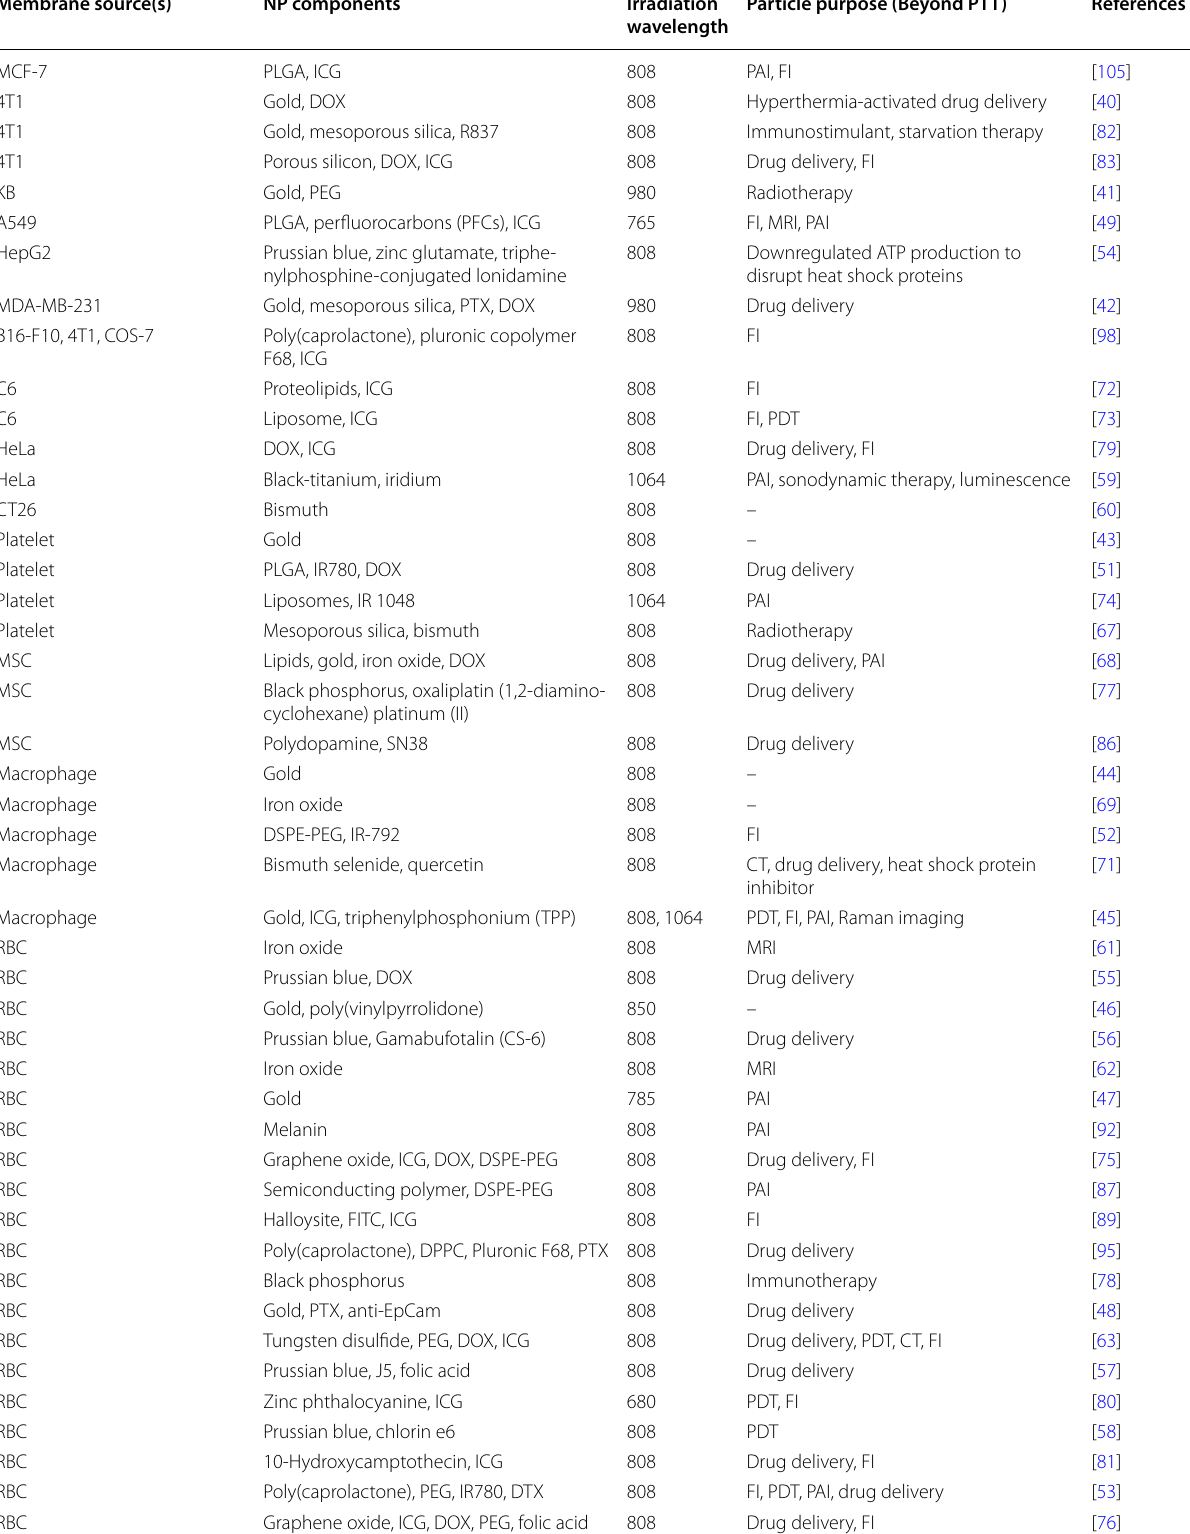
Table 2 Different membrane types used in phototherapeutic NP systems, along with a summary of their characteristics Membrane